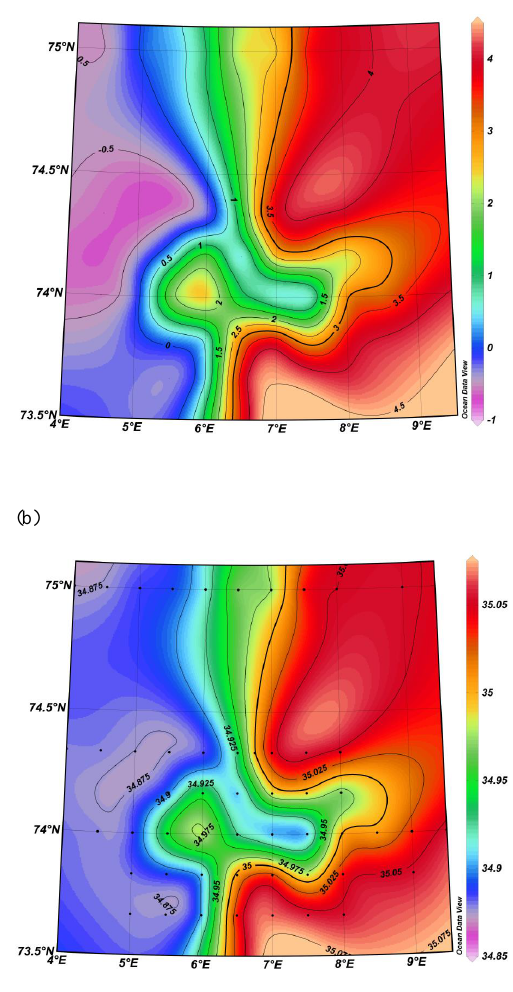
Fig. 8. Summer 1995. (a) Temperature and (b) salinity at Figure 8. Summer 1995. (a) Temperature and (b) salinity at 200 dbar. 6